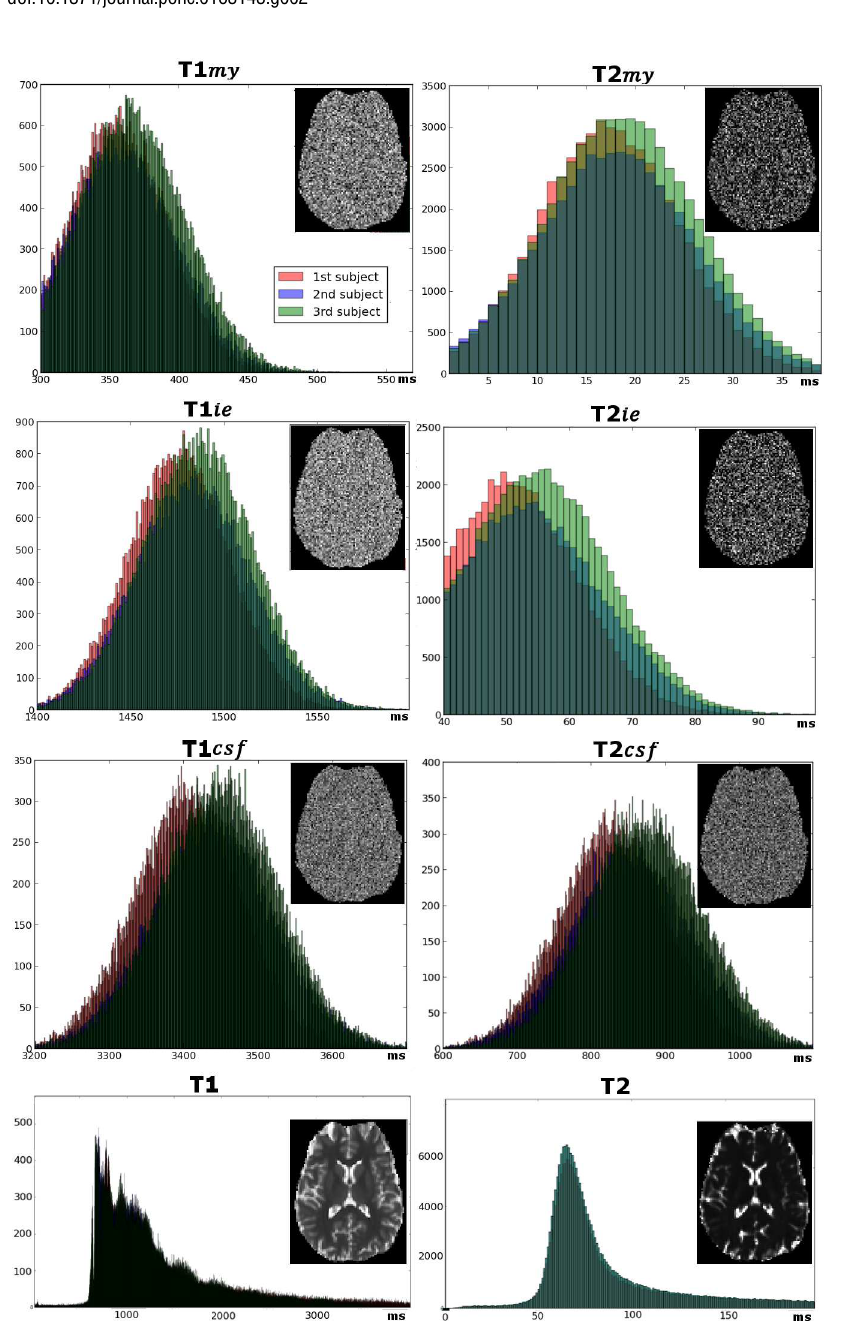
Fig 3. Variations of the compartments relaxation times across voxels. In the first three rows, histograms show distributions of T 1 c and T 2 c estimations(for myelin-related water, intra/extra-cellular water, and CSF compartments) obtained from voxel-wisefitting within the search ranges, across all voxels of the 3 calibrationdatasets. T 1 c and T 2 c maps (presented for subject #3) did not reveal any regionaldependence. In the bottom row, distributions of quantitative T1 and T2 values obtained from mono-exponential fittings at the voxel-level are shown, as well as T1 and T2 maps (subject